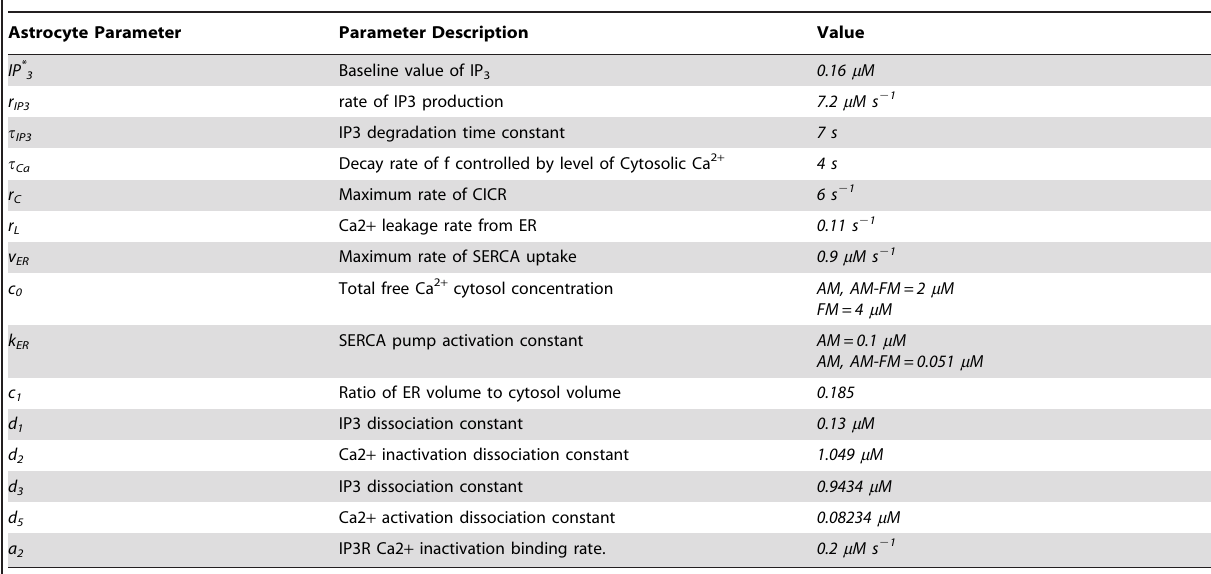
the effects of different encoding schemes on astrocyte-neural communication. Ca 2 + dynamics within the Li-Rinzel model are described by three channels. J pump which models how Ca 2 + is stored within the ER by pumping Ca 2 + out of the cytoplasm into the ER via Sarco- Table 1. Astrocyte